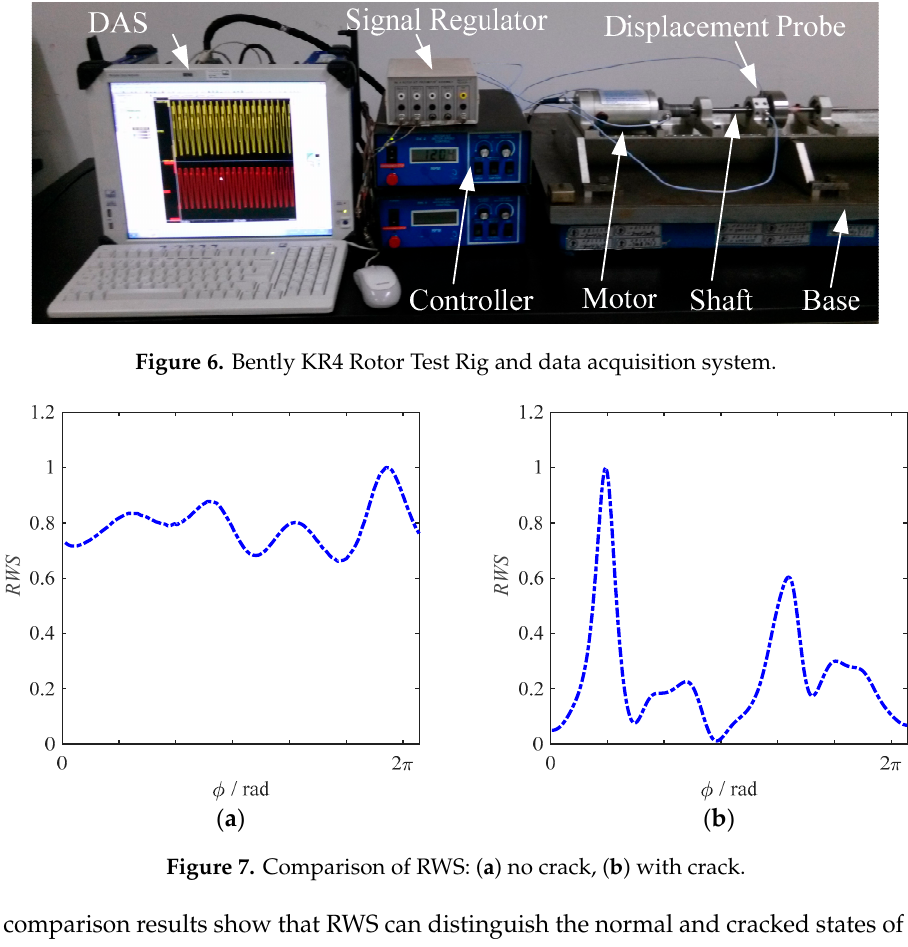
( b ) Figure 8. Line speed curves: ( a ) normal system, ( b ) cracked system. In the steady state response of forced vibrations, the line speeds are mainly controlled by the mutual transformations of the kinetic energy and the potential energy. However, in the cracked rotor system, the non-uniform work of the additional stiffness excitation leads to the distortions of the line speed curves. In Figure 4b, it can be seen that the RWS has two maxima and two minima. The change mechanism of these four special positions will be analyzed in the following part.